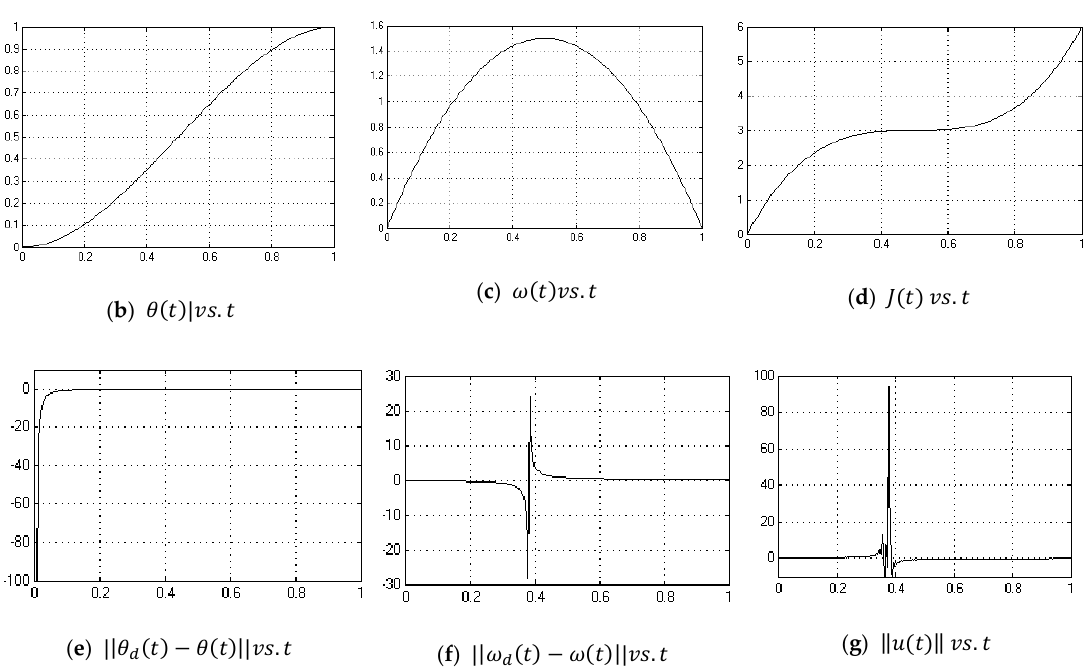
Figure A9. 2DOF PD controlled simulation.